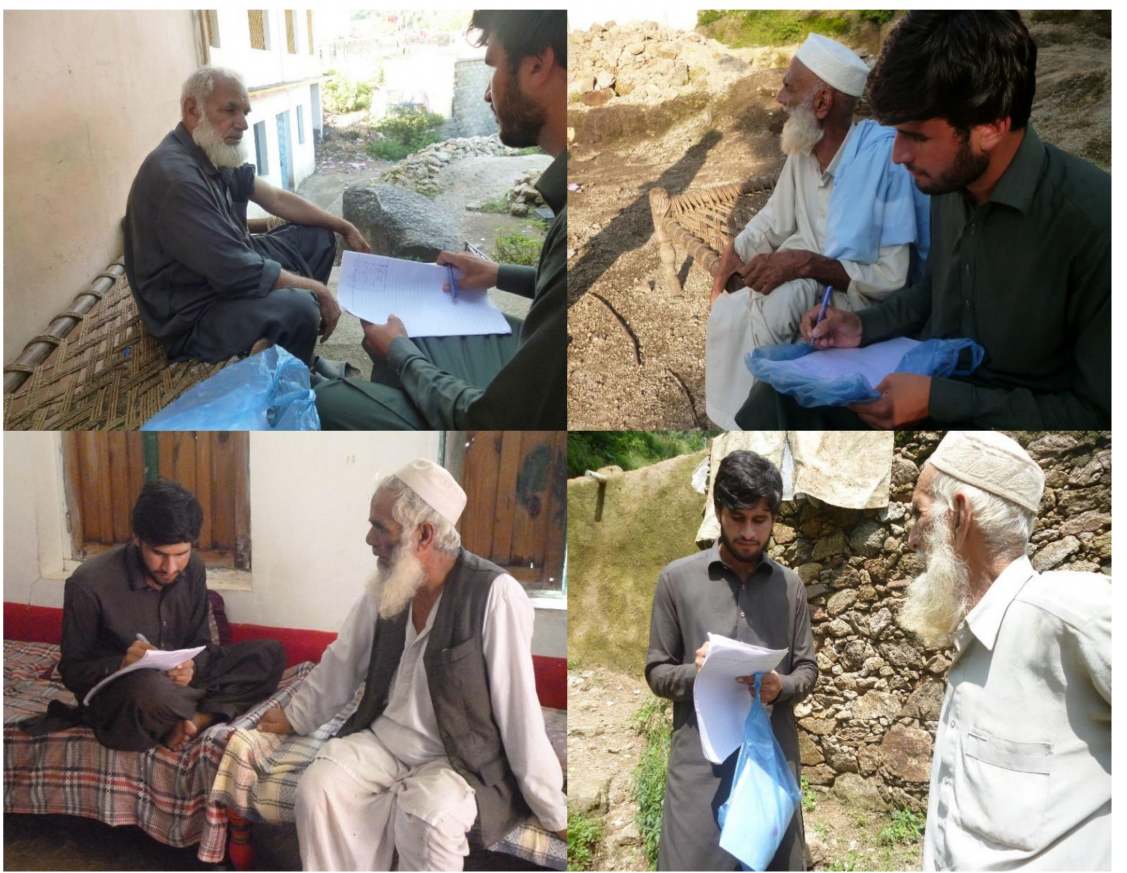
Figure 4. Interviewing local elderly study participants during the